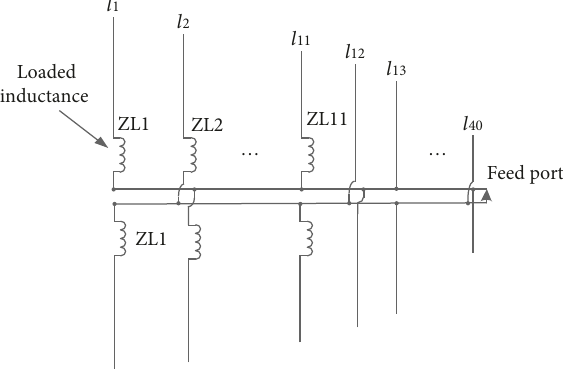
Figure 4: The schematic diagram of inductance lumped